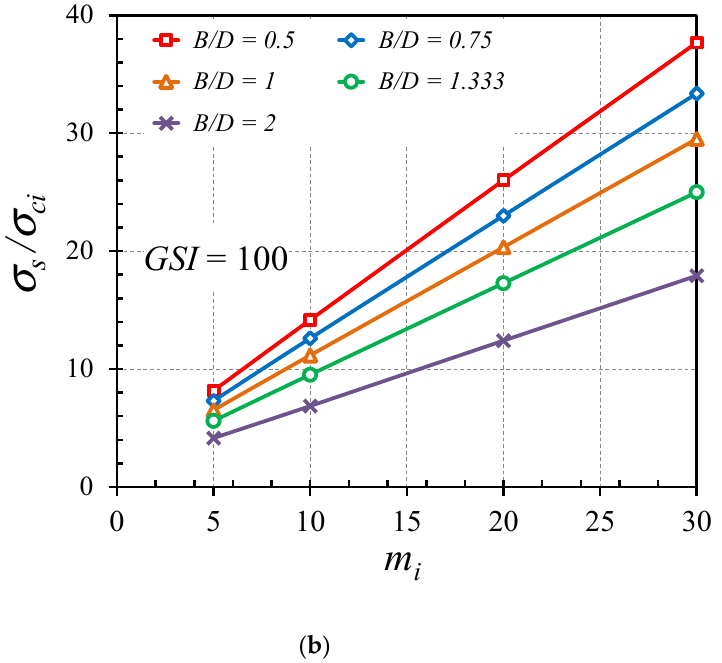
Figure 5. Impact of m i on σ s / σ ci of horseshoe tunnels with C / D = 3 and σ ci / γ D = 1000: ( a ) GSI = 40 and ( b ) GSI = 100.